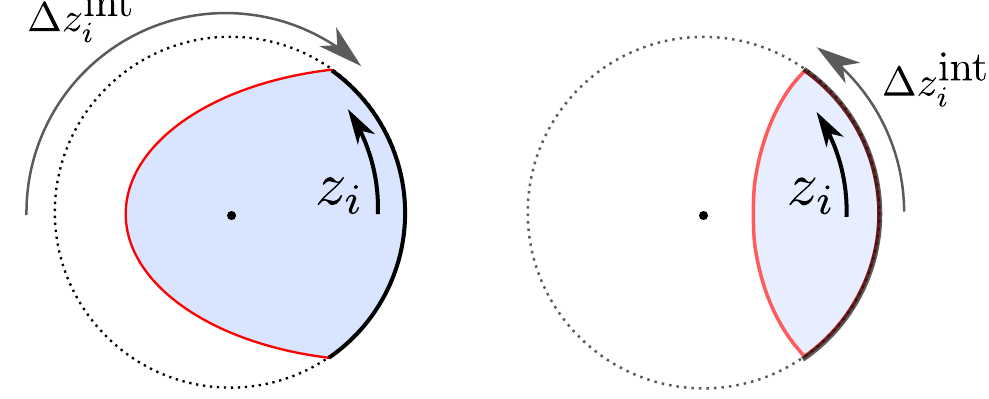
Figure 5 . (Left) In the case that ∆ z int < 0 , the i th gravity region includes the horizon. (Right) In i the case that ∆ z int > 0 , the i th gravity region does not include the i